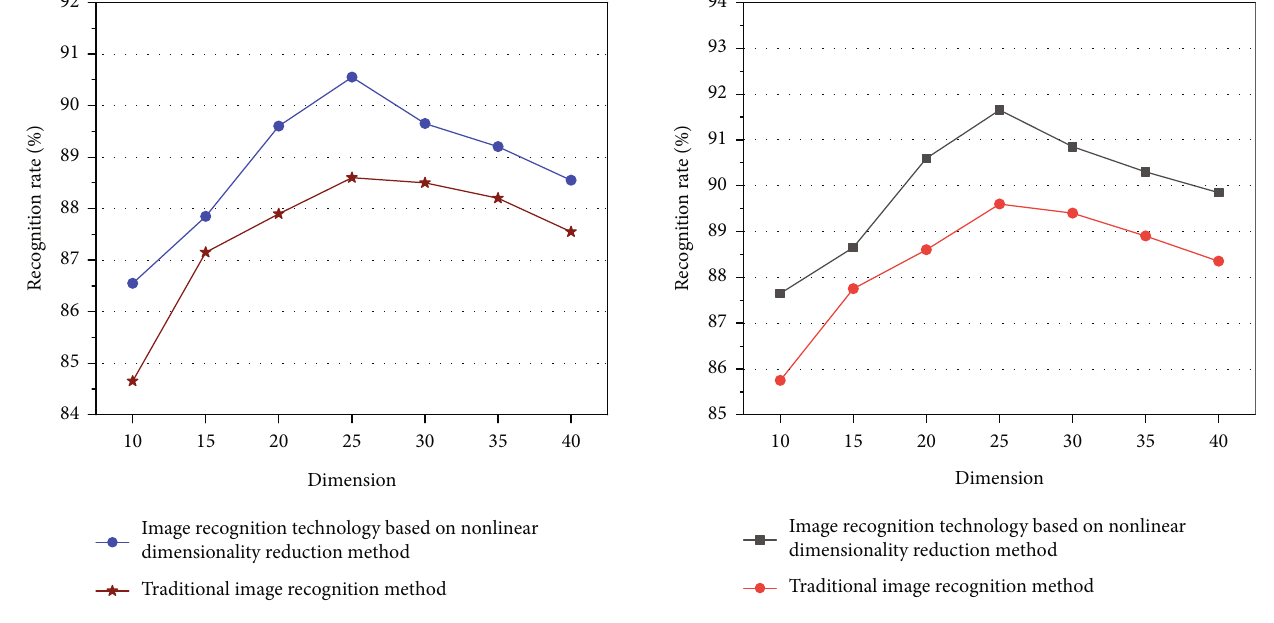
Figure 7: E ffi ciency analysis of commodity price identi fi cation. Figure 6: E ffi ciency analysis of commodity price identi fi